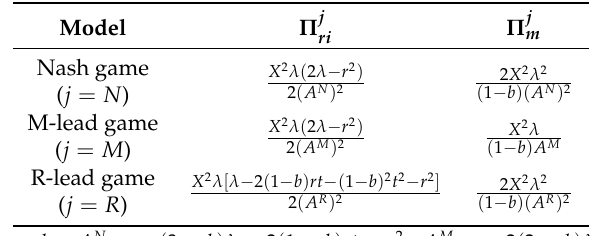
Table 2. Optimal profits with both retailers’ investment.